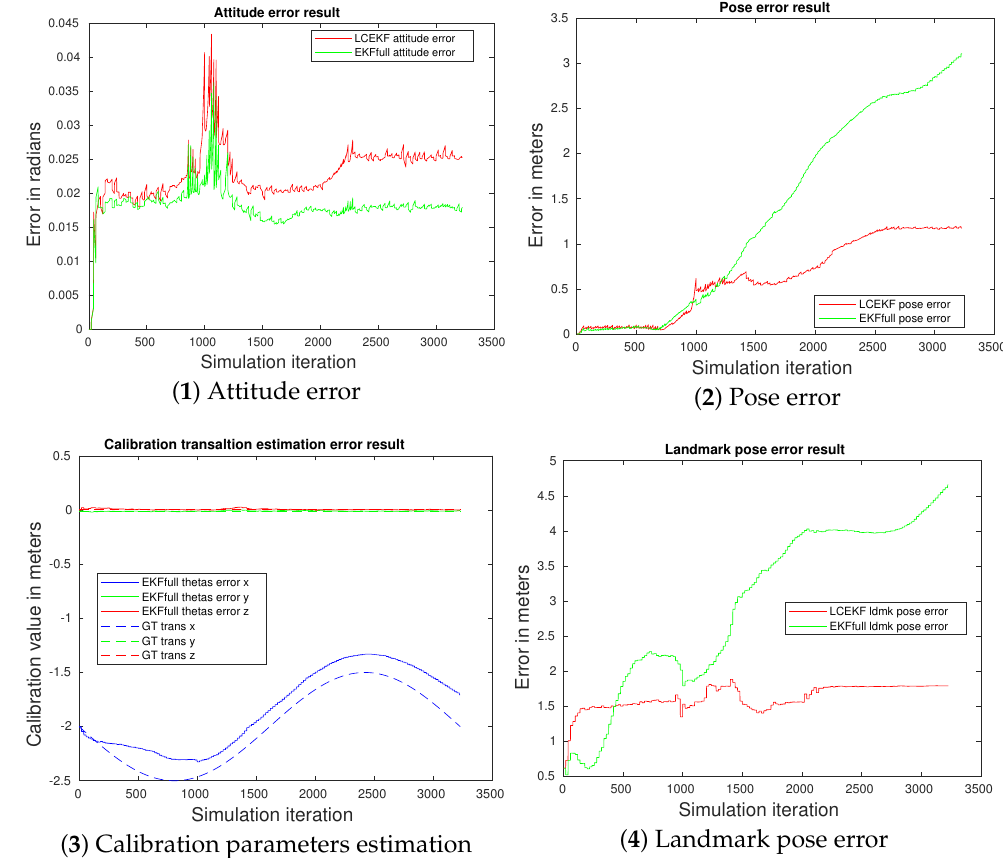
Figure 17. SLAM without the IMU and smooth sinusoidal noise. With underestimated random walk for K parameters, the estimation was not performed properly, making the EKFfull diverge. Note that there was no impact on the LCEKF as the K calibration parameters were not estimated.